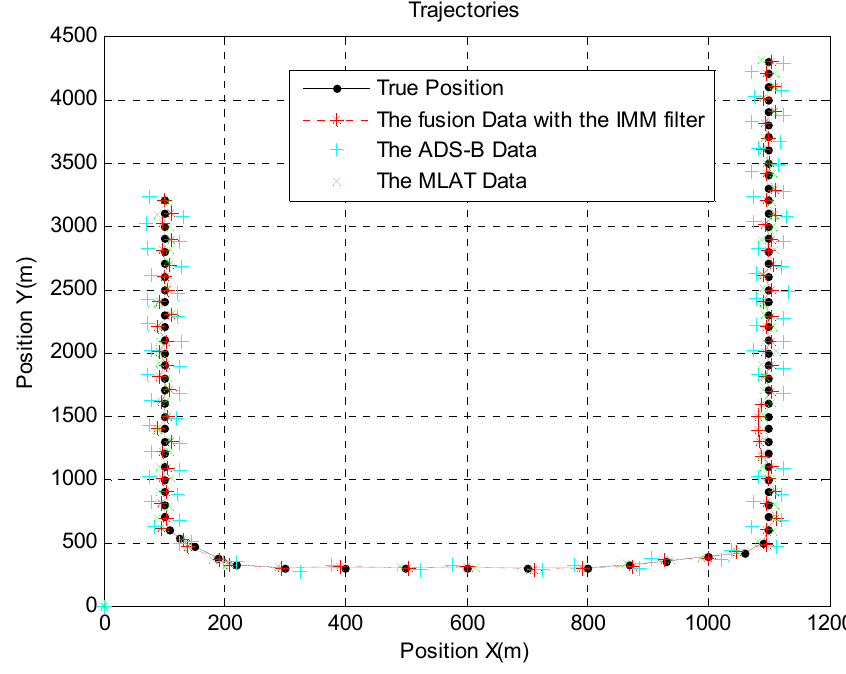
Figure 7. Aircraft trajectory at 16 km from the airport.